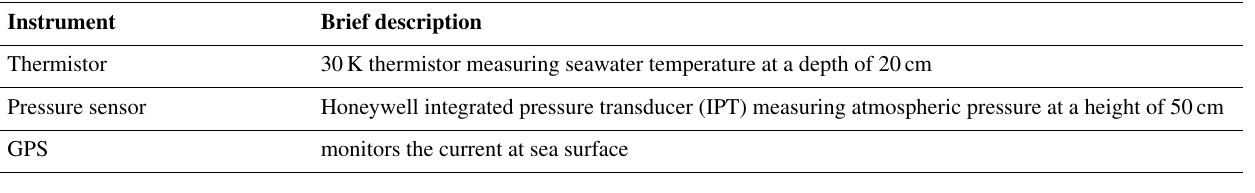
Table B31. Pacific Gyre barometer–temperature drifters.